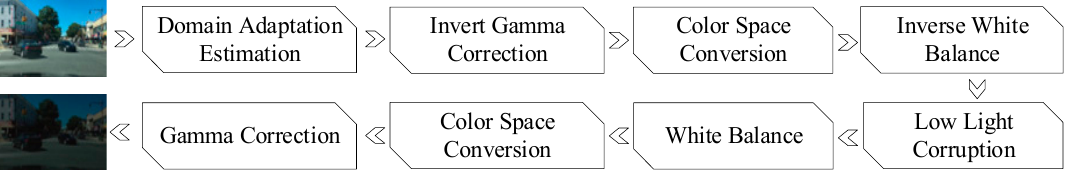
Figure 5. The pipeline of low-illumination degrading transformations.